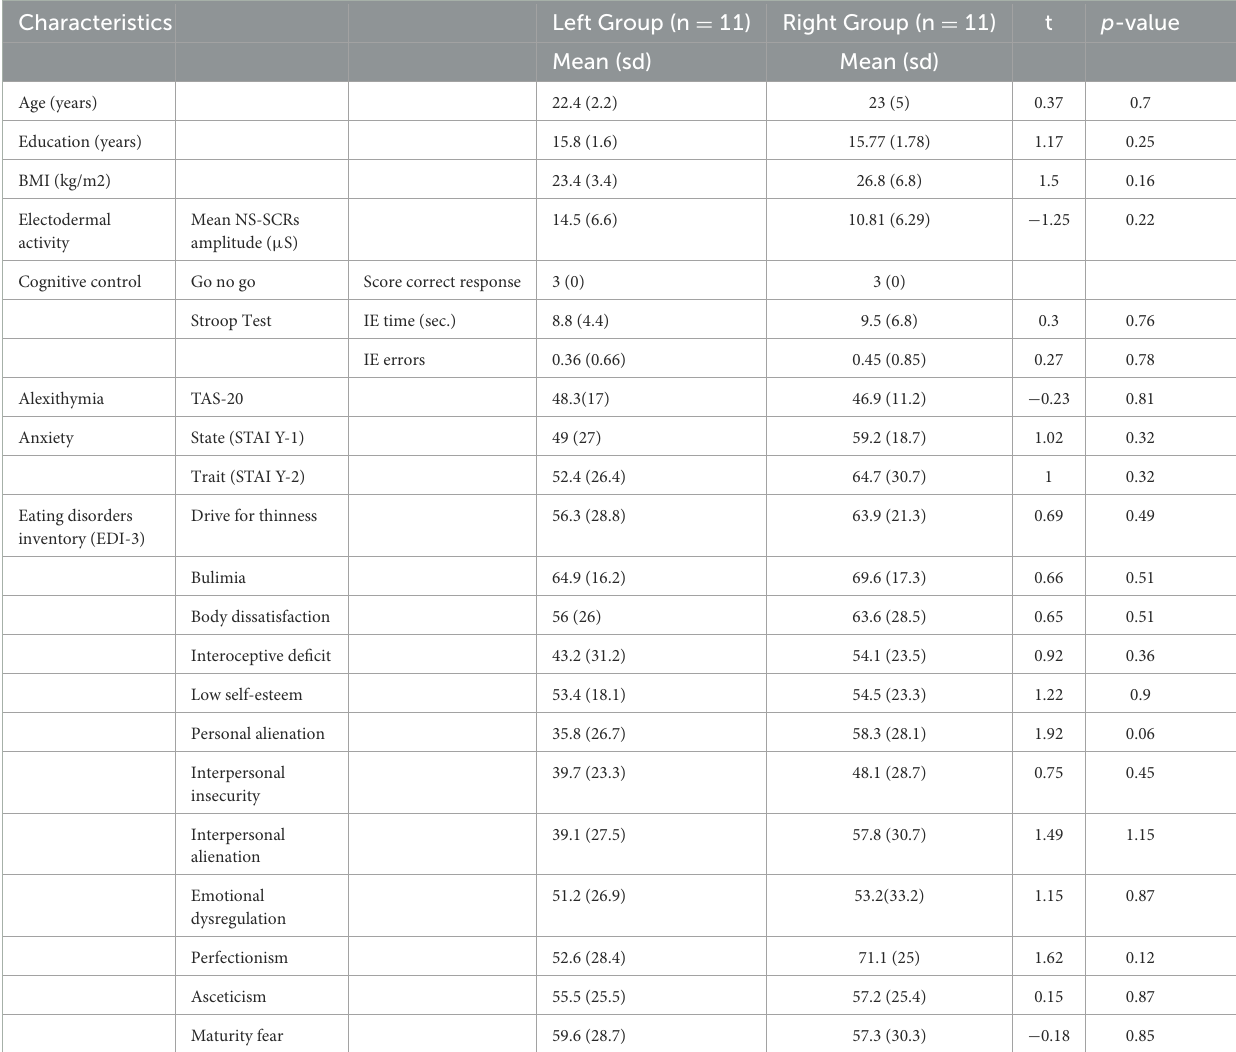
TABLE 1 Characteristics of the two groups of participants.